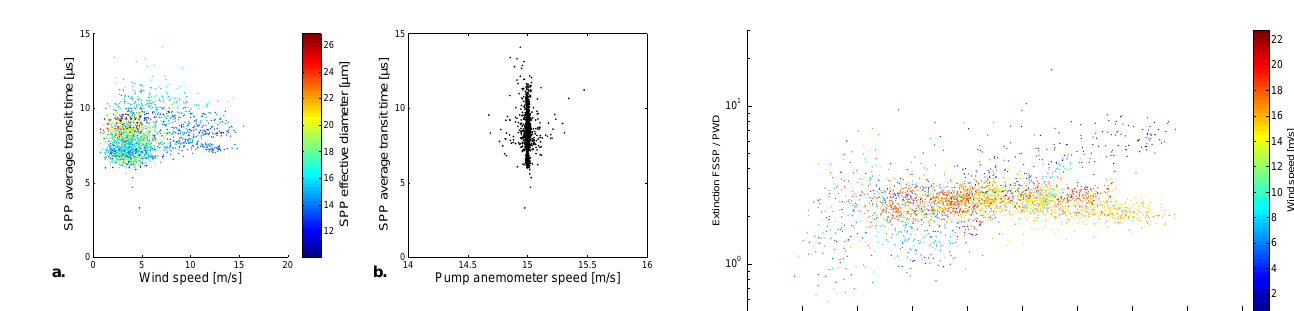
Figure 13. SPP average transit time as a function of the ambient wind speed (a) and of the pump suction speed (b) . The colors show the effective diameter measured by the SPP. The data are averaged over 1min.